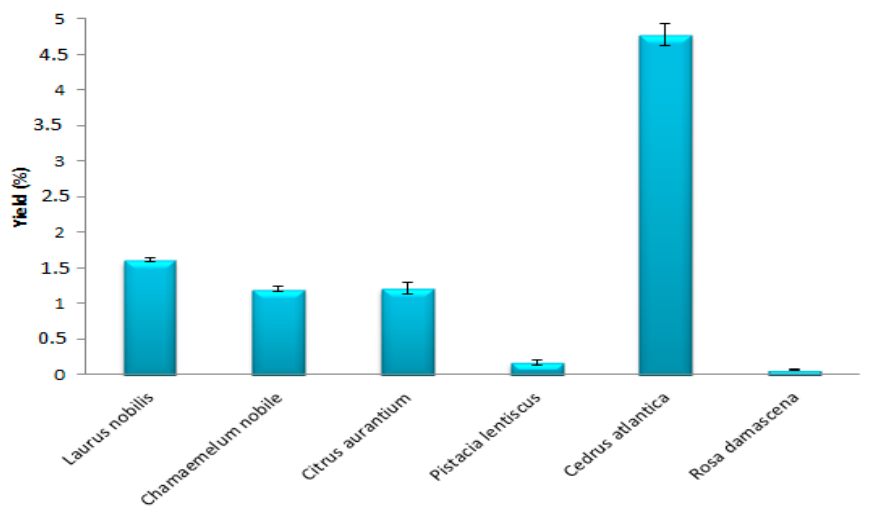
Figure 1. Yields of EOs of the plant species.